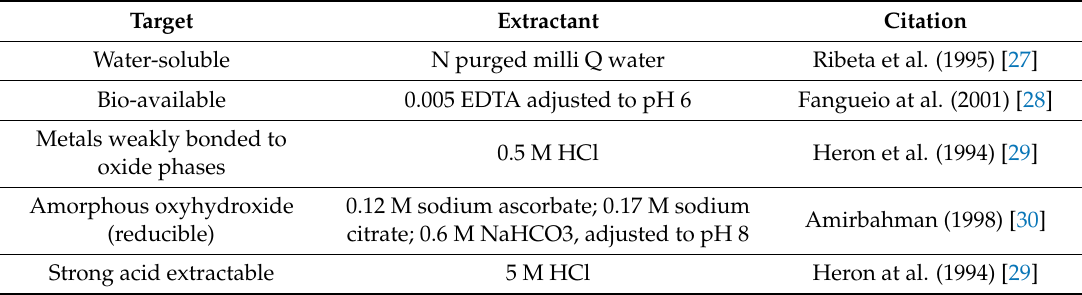
Table 1. Selective geochemical extractions